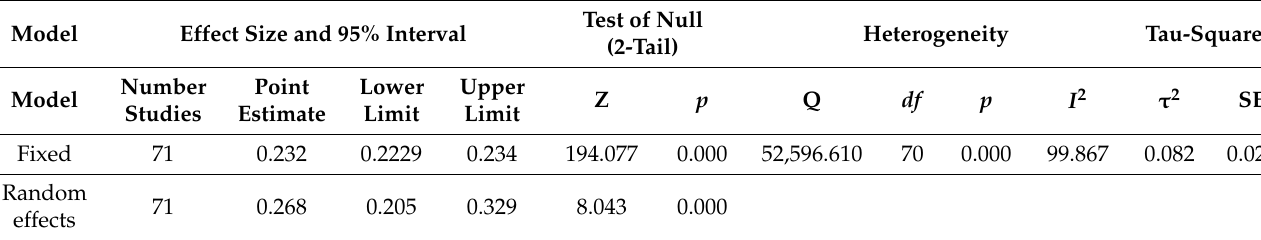
Table 2. Distribution of overall effect values and heterogeneity test